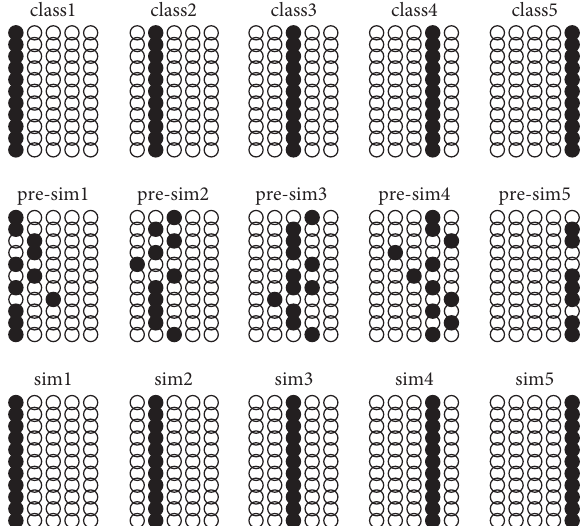
Figure 6: Human resource management performance evaluation index grade coding results.